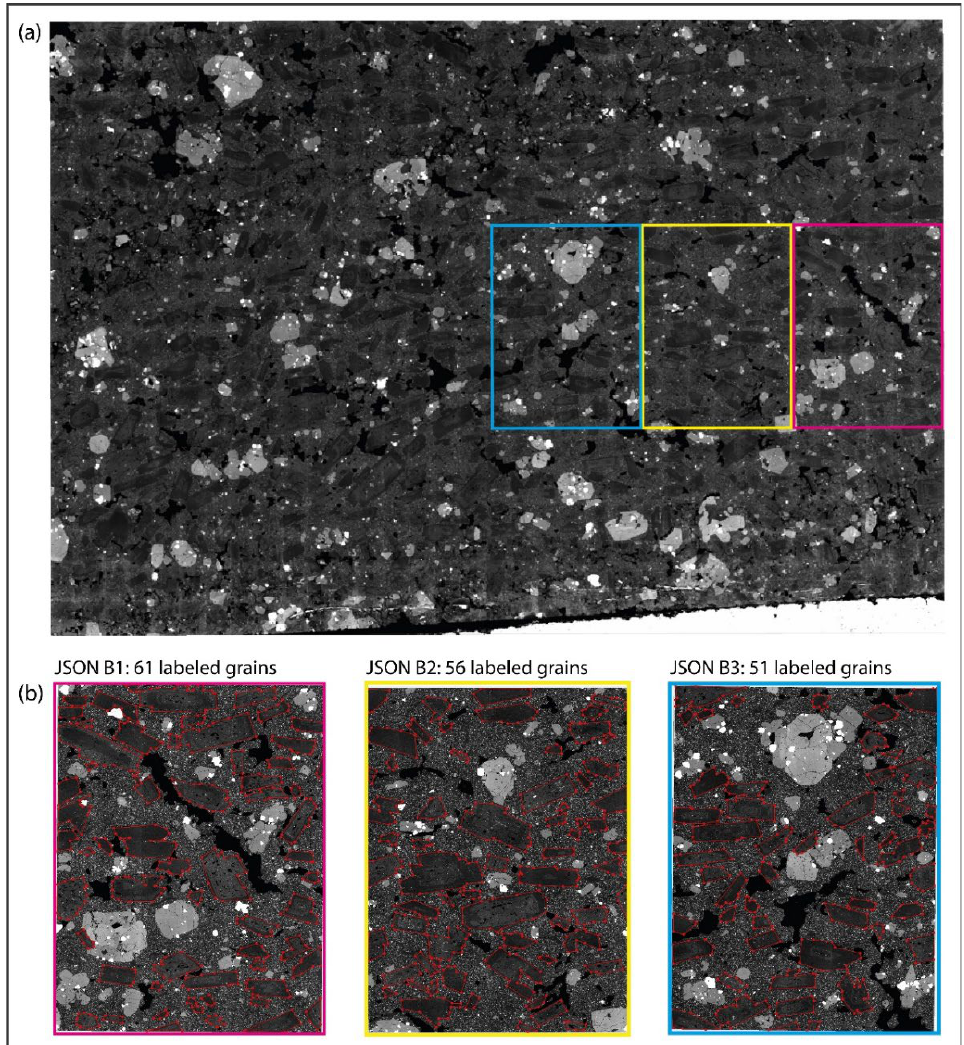
Figure 4. ( a ) The BSE microphotograph of rock thin section. ( b ) The three JSON files where we label mineral grains as the training and validation datasets in model training. The JSON file with the pink edge, yellow edge, and sky blue edge corresponding to the place circled by the pink, yellow, and sky blue rectangles in ( a ).